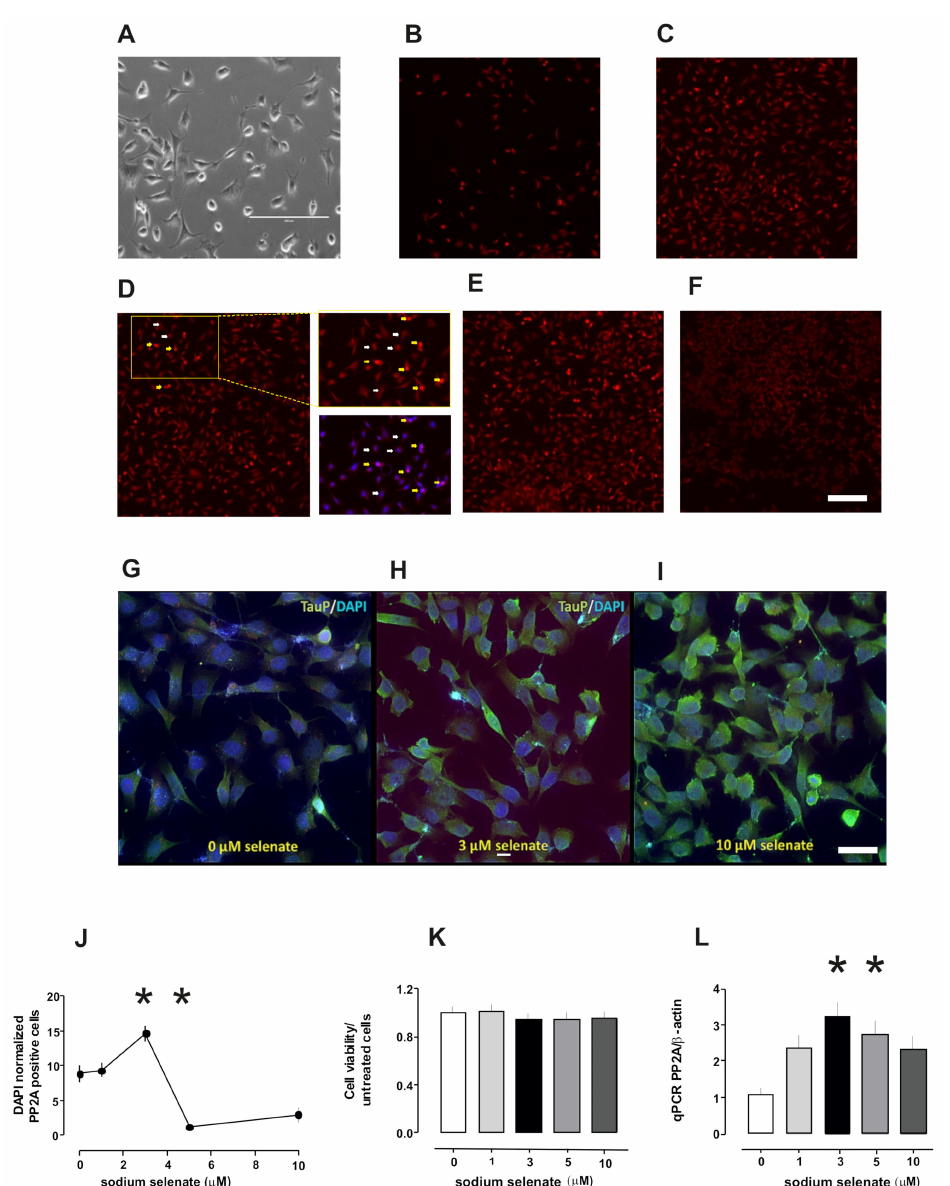
Figure 1. Sodium selenate treatment increases PP2Ac levels in differentiated SHSY-5Y cells without affecting cell viability. ( A ) A representative image of retinoic acid differentiated SHSY-5Y neurons with processes (scale bar 200 µ m). ( B ) Sodium selenate treatment (0 µ M) ( C ) 1 µ M ( D ) 3 µ M ( E ) 5 µ M and ( F ) 10 µ M, representative images of SHSY-5Y cells incubated with sodium selenate and stained with PP2Ac (red). Inset from ( D ) (yellow box) indicates two population of PP2A-positive cells with differential level of expression. High PP2A expression (yellow arrow) and low expression (white arrow). ( G – I ) Merged images of cells stained with nuclear marker DAPI (blue) and pTau (S202) (green) for 0, 3 and 10 µ M sodium selenate treatment. Scale bar in top images ( F ) 100 µ m; lower images ( I ) 50 µ m). ( J ) Line-plot of PP2Ac positive cells for different doses of sodium selenate. K. Histogram plot of cell viability after different sodium selenate treatment. ( L ) Histogram plot qPCR of PP2Ac transcripts with sodium selenate treatment (asterisks p < 0.05, see also